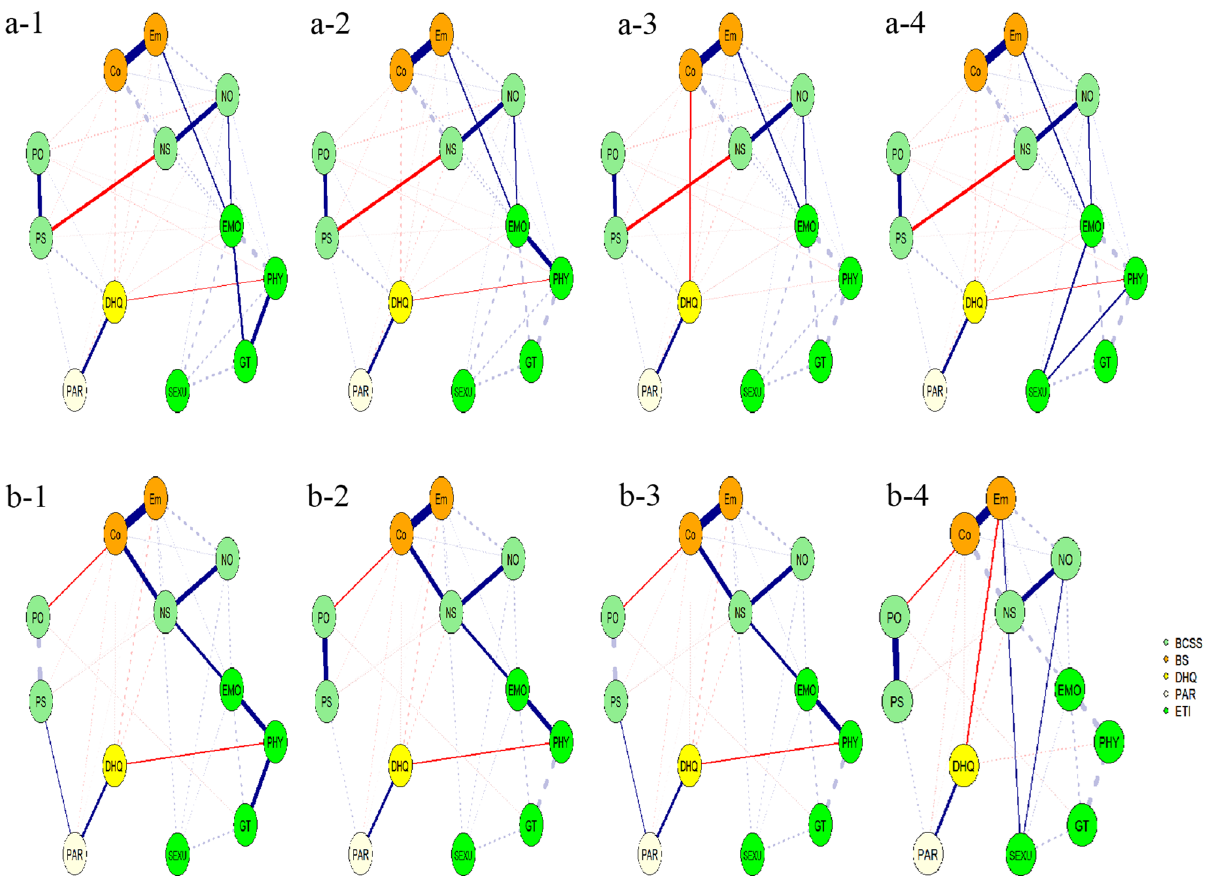
Figure 3. Shortest pathways from GT, EMO, PHY or SEXU to negative life style in ( a ) patients ( a-1 , a-2 , a-3 and a-4 ) and ( b ) controls ( b-1 , b-2 , b-3 and b-4 ). Thicker solid lines represent stronger connections; Dashed lines represent background connections existent within the network that are less relevant when investigating shortest paths. Abbreviation: same as in the Fig. 1. The R-packages ‘networktools (version 1.4.0 and URL https:// CRAN.R- proje ct. org/ packa ge= netwo rktoo ls)’ and ‘igraph (version 1.2.7 and URL https:// CRAN.R- proje ct. org/ packa ge= igraph)’ were